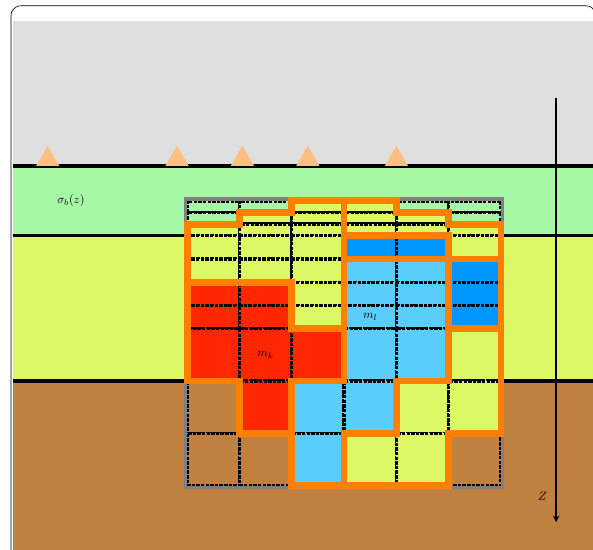
Fig. 2 Sketch of mask parametrization. Grey line depicts the boundaries of the anomaly; black dotted lines denote the cells used in forward modelling; orange lines show the inversion domain